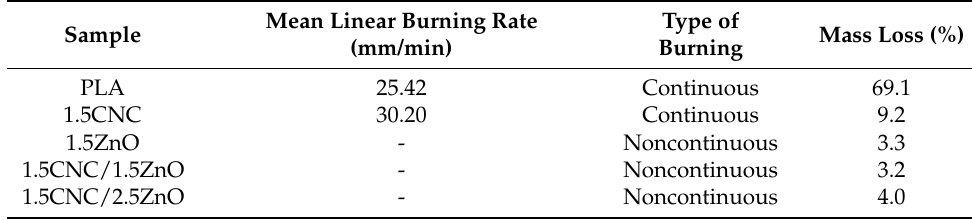
Table 4. Flame retardancy observed for PLA and composites from horizontal burning test.